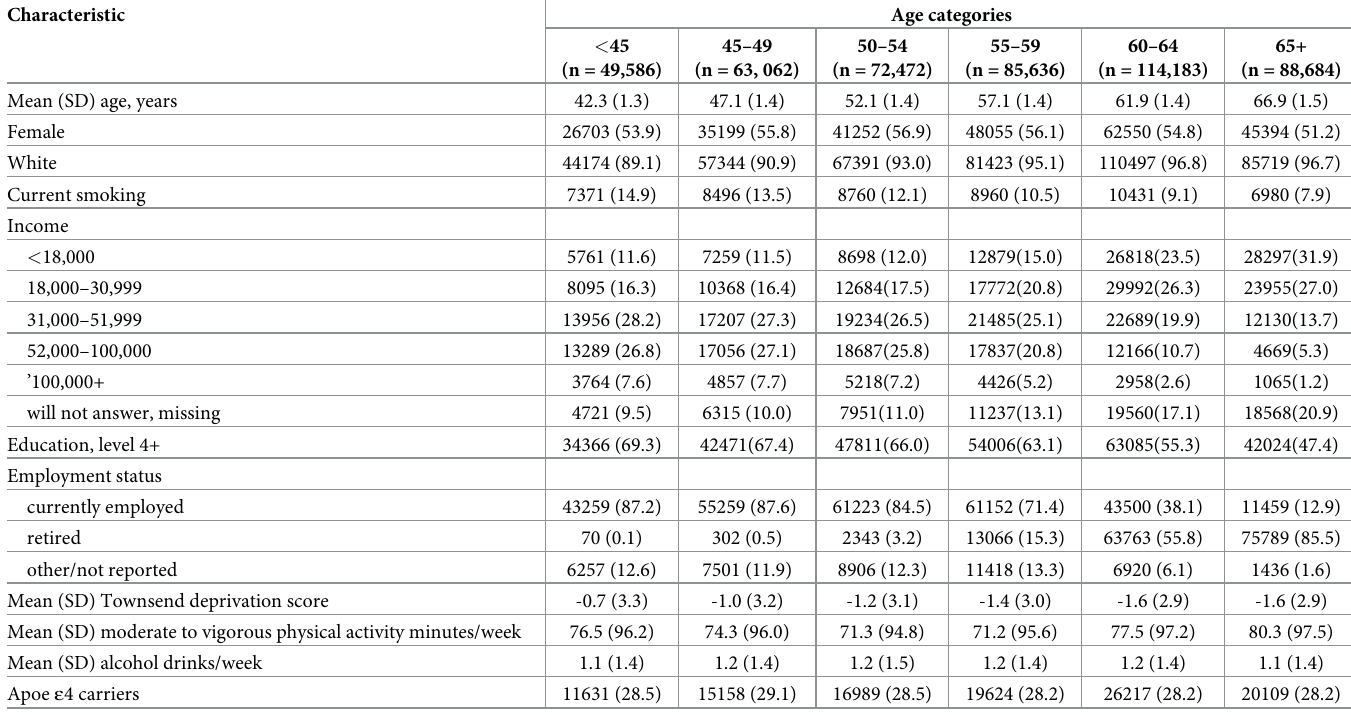
Table 1. Baseline characteristics of study population a